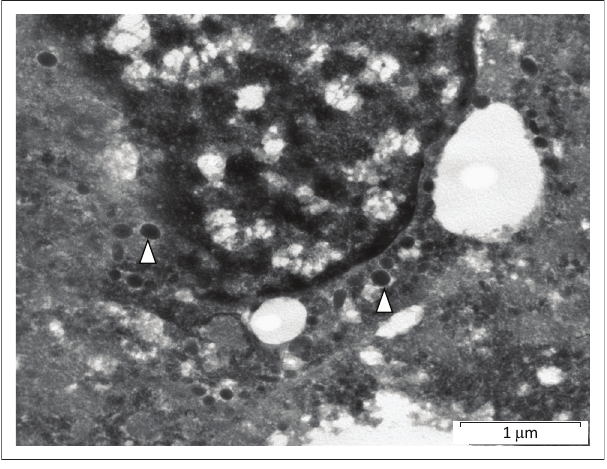
FIGURE 8: Transmission electron micrograph; renal paraganglioma. Intra- cytoplasmic (peri-nuclear) spherical, electron-dense-core neurosecretory granules within a neoplastic cell (white arrowheads).